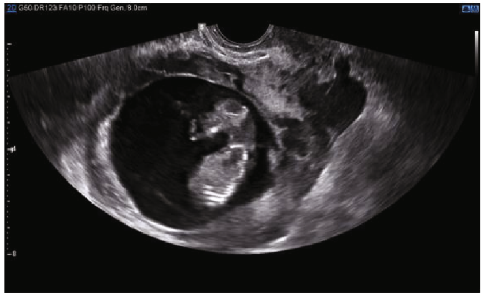
Figure 2: Ultrasound imaging with radiology report noting thickening of the endometrium at the fundus. The gestational sac appears at the lower segment with bulging towards the bladder. On the transvaginal area, there is signi fi cant vascularity surrounding the gestational sac and there appears to be very little myometrium.